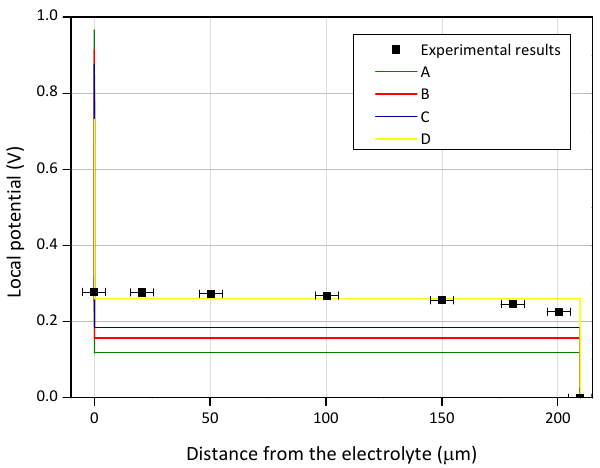
Figure 4. Experimentally measured (marked line) and numerically calculated (straight line) potential profile along the PEDOT:PSS channel. The calculated profiles were computed with various initial hole concentrations: A —10 18 cm − 3 ; B —5·10 18 cm − 3 ; C —10 19 cm − 3 ; D —5·10 19 cm − 3 . concentrations: A —10 18 cm − 3 ; B —5 · 10 18 cm − 3 ; C —10 19 cm − 3 ; D —5 · 10 19 cm − 3